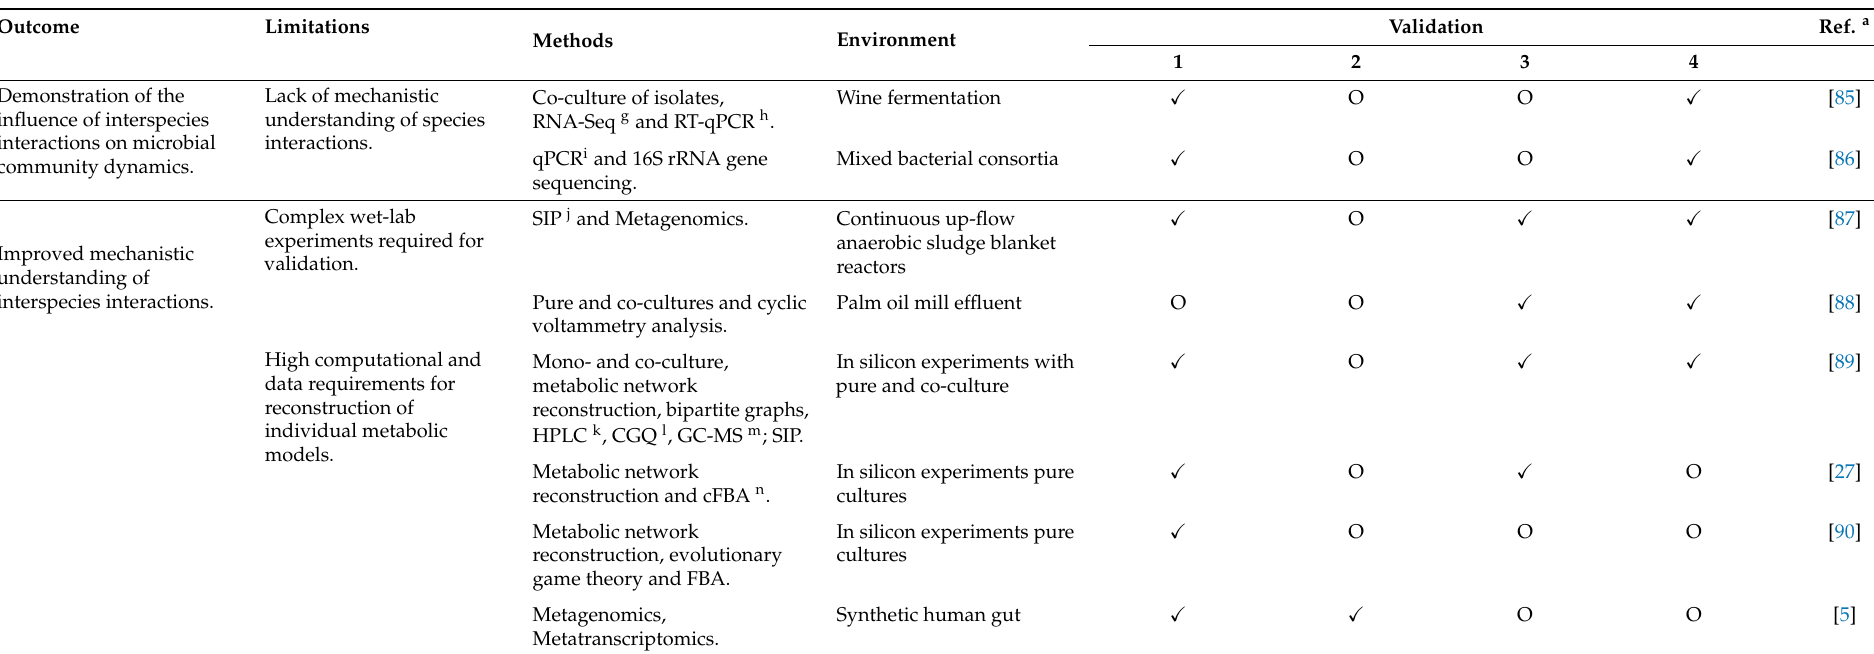
Table 2. Outcomes and limitations of different methods to study microbial interactions. We assigned four validation strategies to confirm microbial interaction as following: (1) Expression or activity assays (e.g., transcriptomics, proteomics, metabolomics, RT-PCR, FBA); (2) 3D structure and spatial variability; (3) Substrate specificity; and, (4) Temporal variability. Outcome Demonstration of the influence of interspecies interactions on microbial community